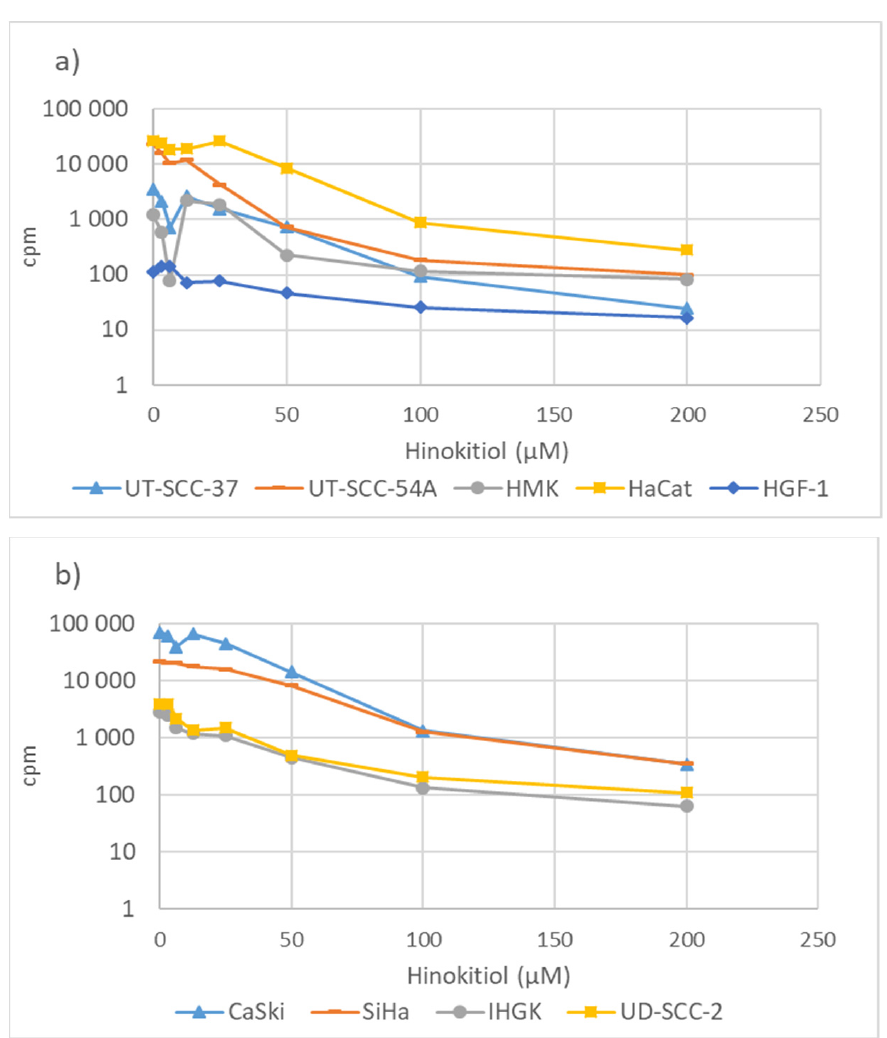
Figure 2. Cell proliferation. The cells were exposed to different hinokitiol concentrations (3.1, 6.125, 12.5, 25, 50, 100, and 200 µ M) in 96-well plates for 24 h and the cell proliferation was measured 12.5, 25, 50, 100, and 200 μ M) in 96 ‐ well plates for 24 h and the cell proliferation was measured by